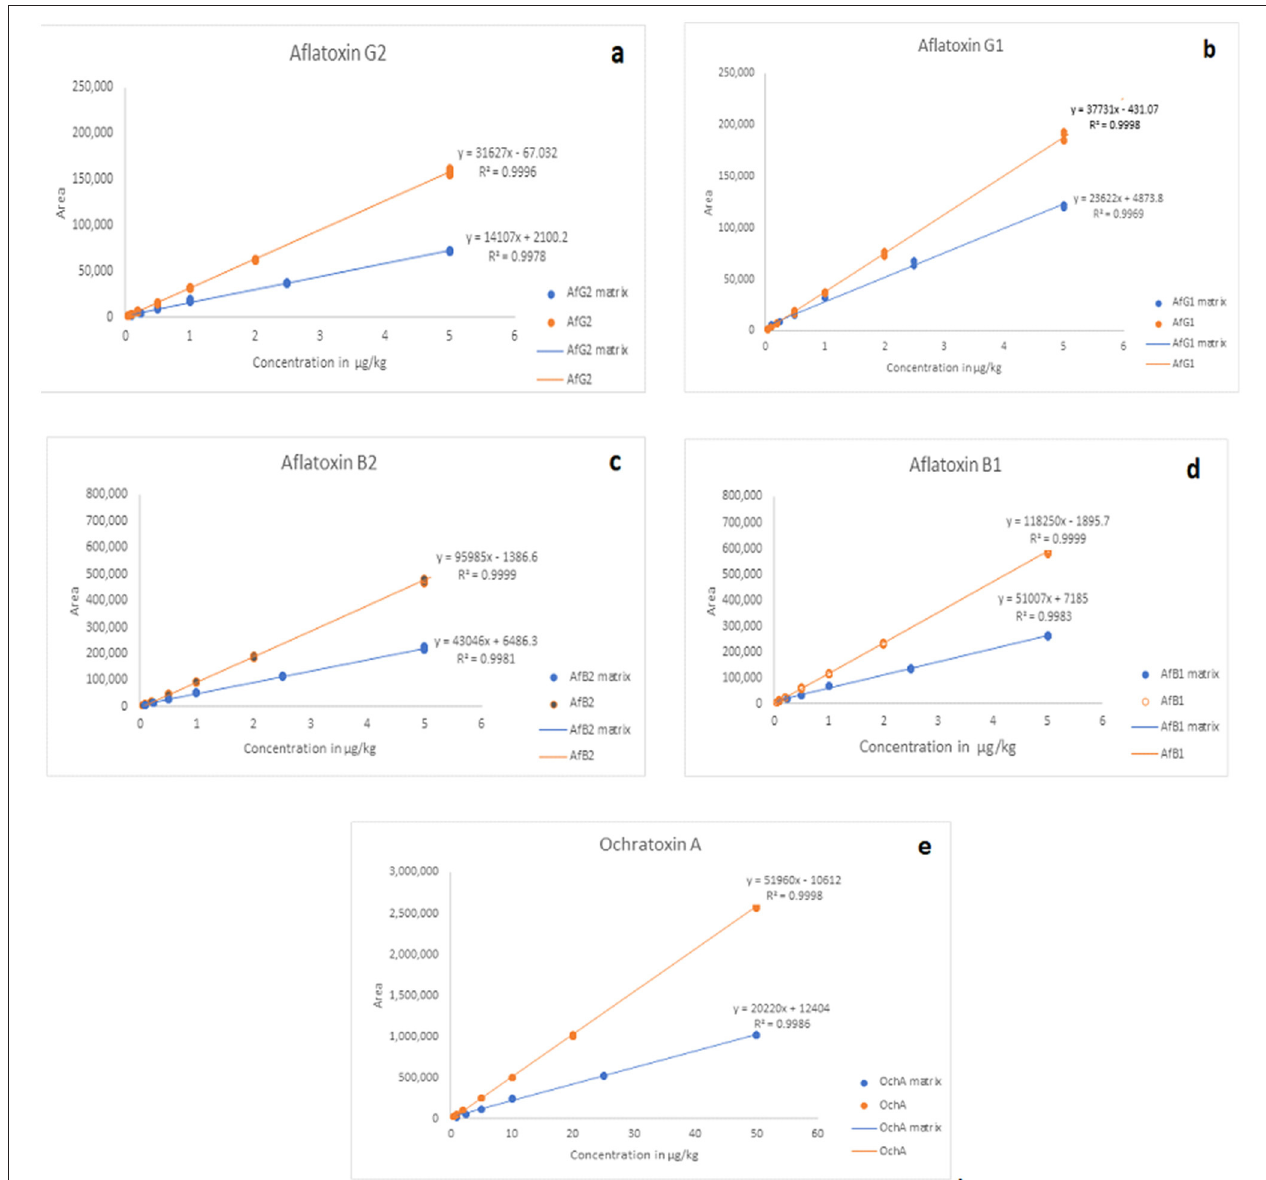
FIGURE 5 | Comparison of matrix effects for AfG2 (a) , AfG1 (b) , AfB2 (c) , AfB1 (d) , and OchA (e) . Calibration curves of standard solutions of mycotoxins (red line) and calibration curves of standard solutions of mycotoxins in post immunoaffinity column matrix (blue